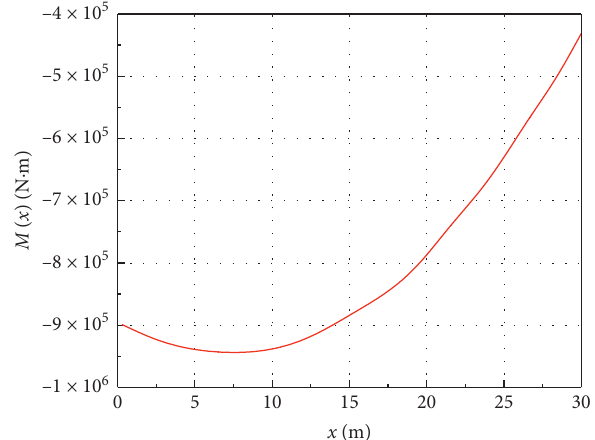
Figure 3: The variation of bending moment (I).